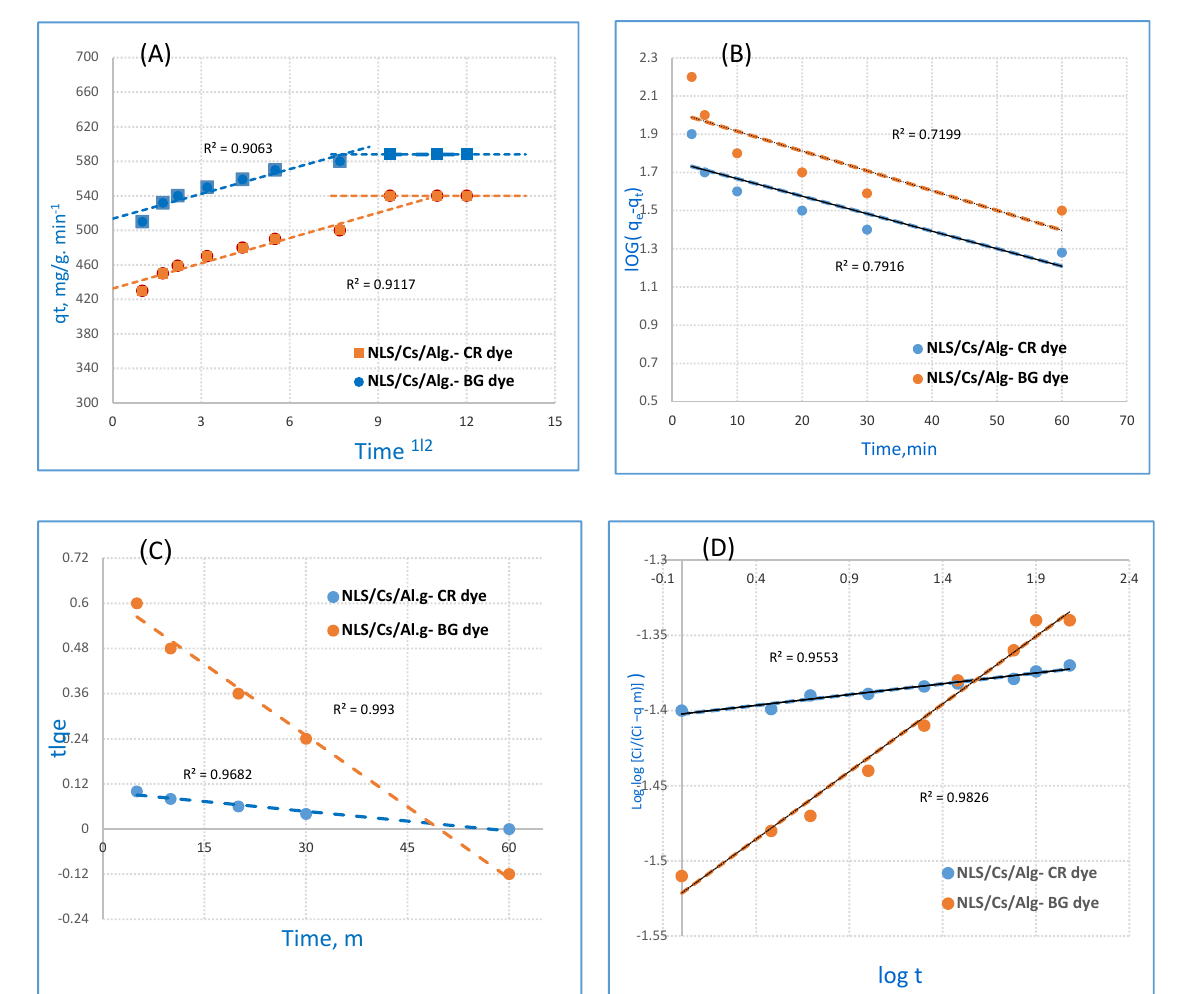
Figure 5. Nanocomposite: ( A ) Morris–Weber equation, ( B ) pseudo–first–order (PFO), ( C ) pseudo–second–order (PSO), and ( D ) Bangham.